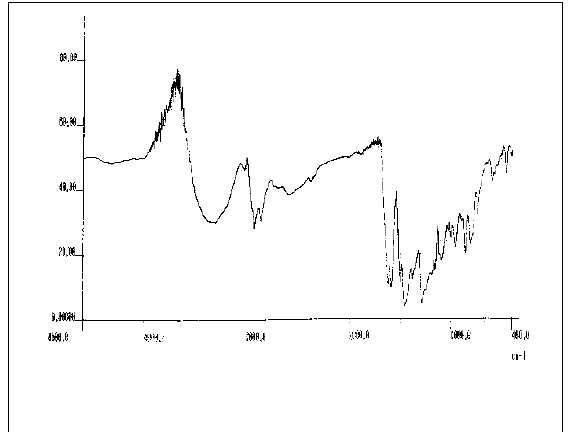
Figure 2: IR spectra of m-CHF-I resin.